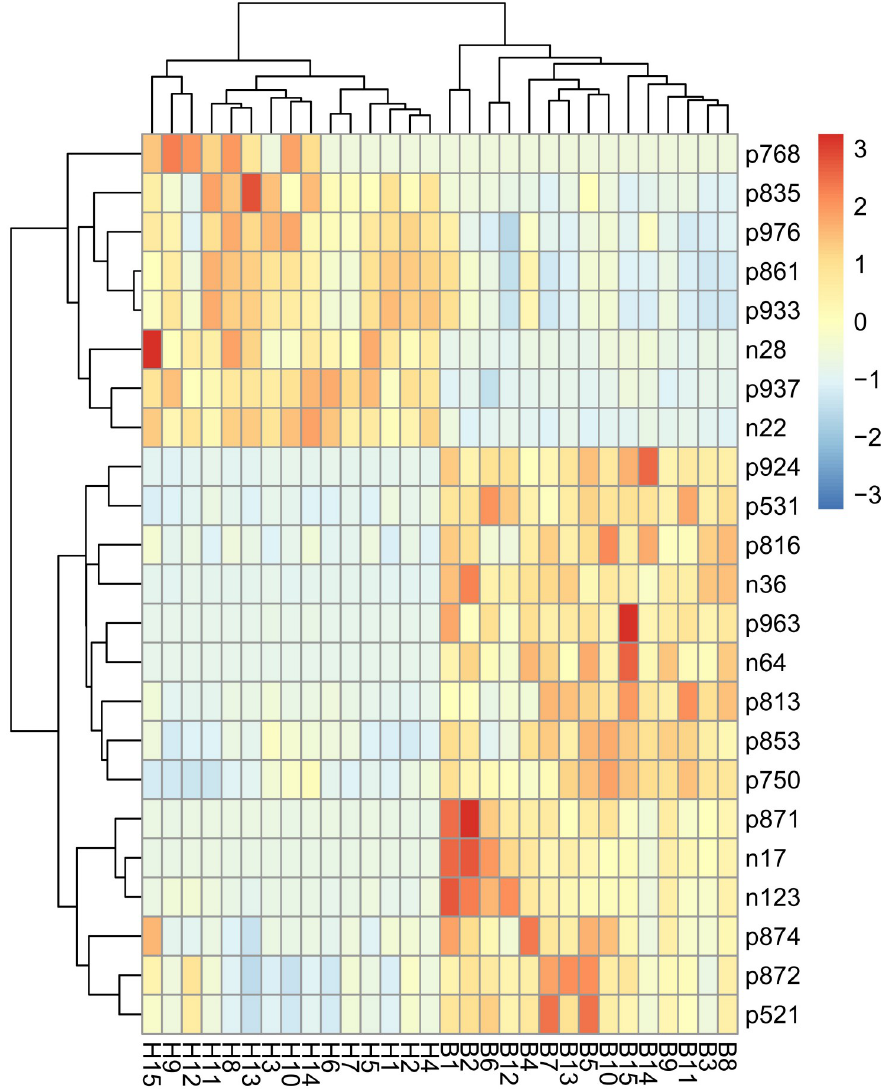
Fig 2. Heatmap of significantly differential metabolites between Italian Mediterranean buffaloes’ milk and Chinese Holstein cows’ milk. The horizontal axis represents milk samples; The vertical axis represents